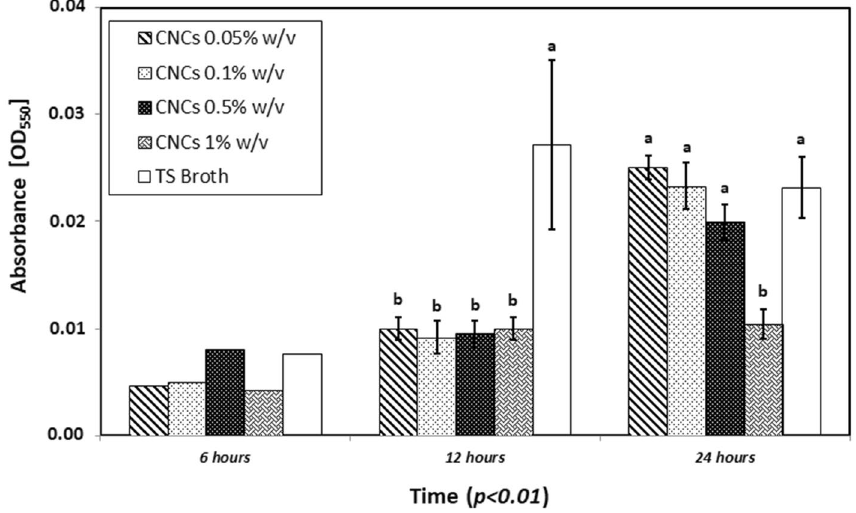
Figure 3. In vitro biofilm formation of Pseudomonas savastanoi pv. savastanoi by different cellulose nanocrystals concentrations (0.05, 0.1, 0.5, 1% w/v) at 6, 12 and 24 h. Tryptone soy broth (TS Broth) was used as control. Statistical significance was based on a p -value < 0.01. Error bars represent the standard deviation between eight replicates. In vitro experiments were conducted thrice, and the effect of the experiment was not